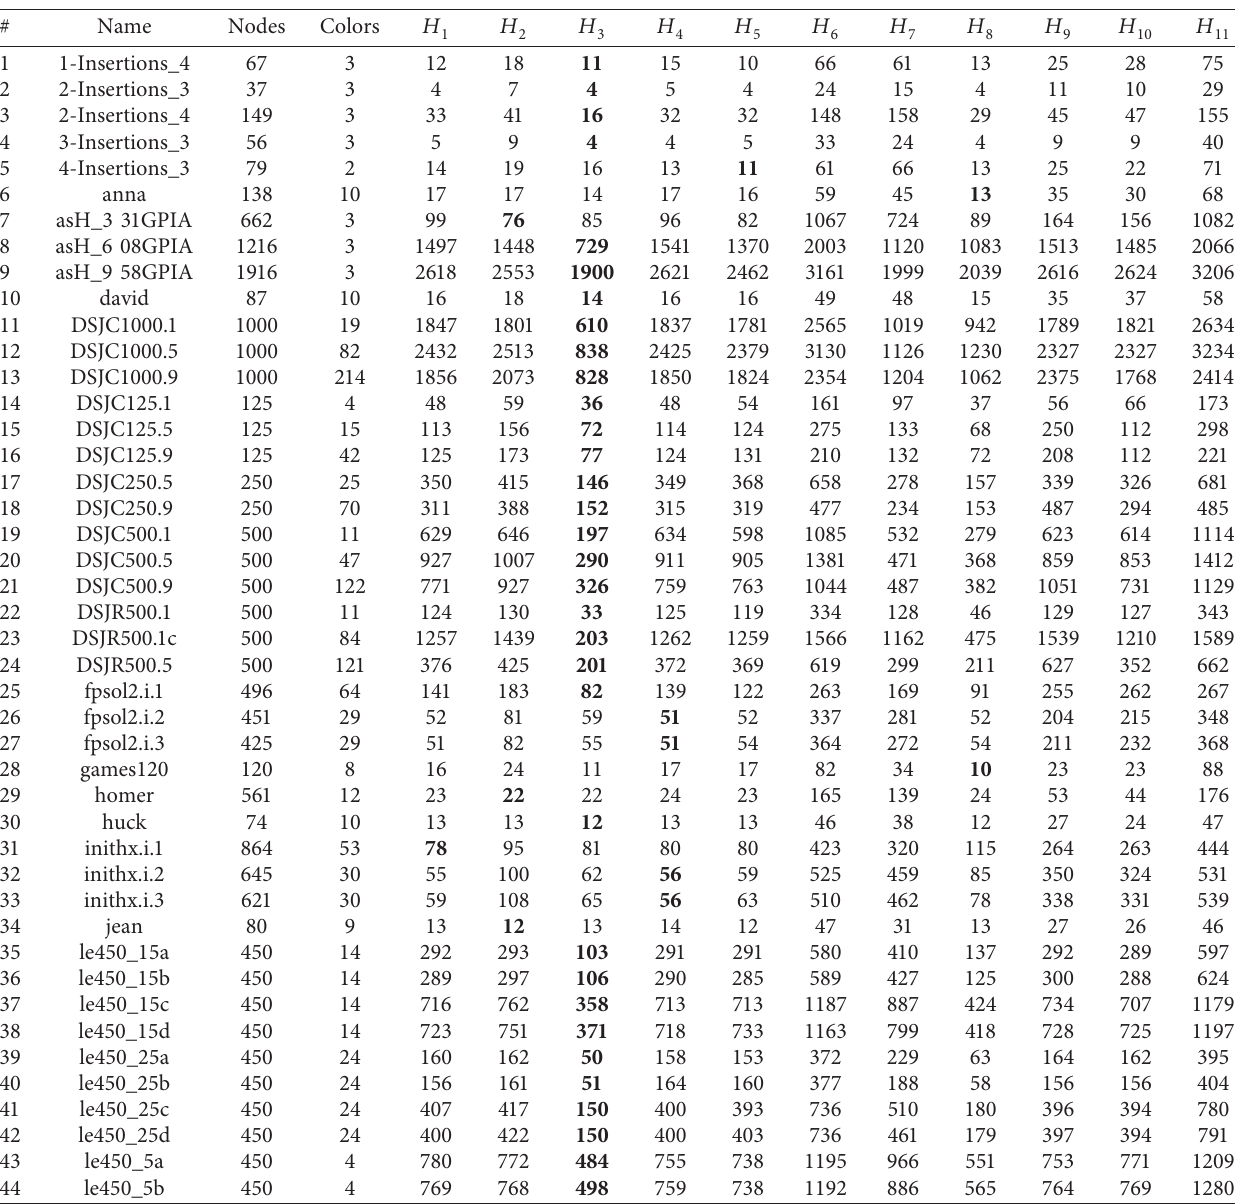
Table 5: Heuristics results for graph coloring